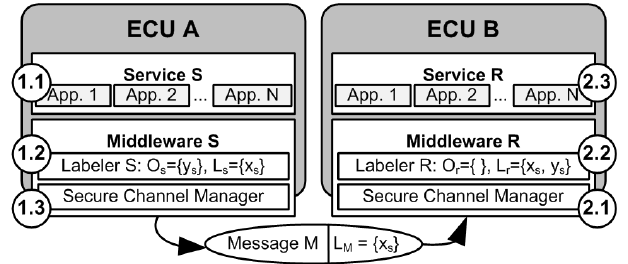
Figure 5. DIFC-based communication between 2 services R and S. L and O are the label and ownership of a service. x s , y s , and x i are secrecy and integrity tags.